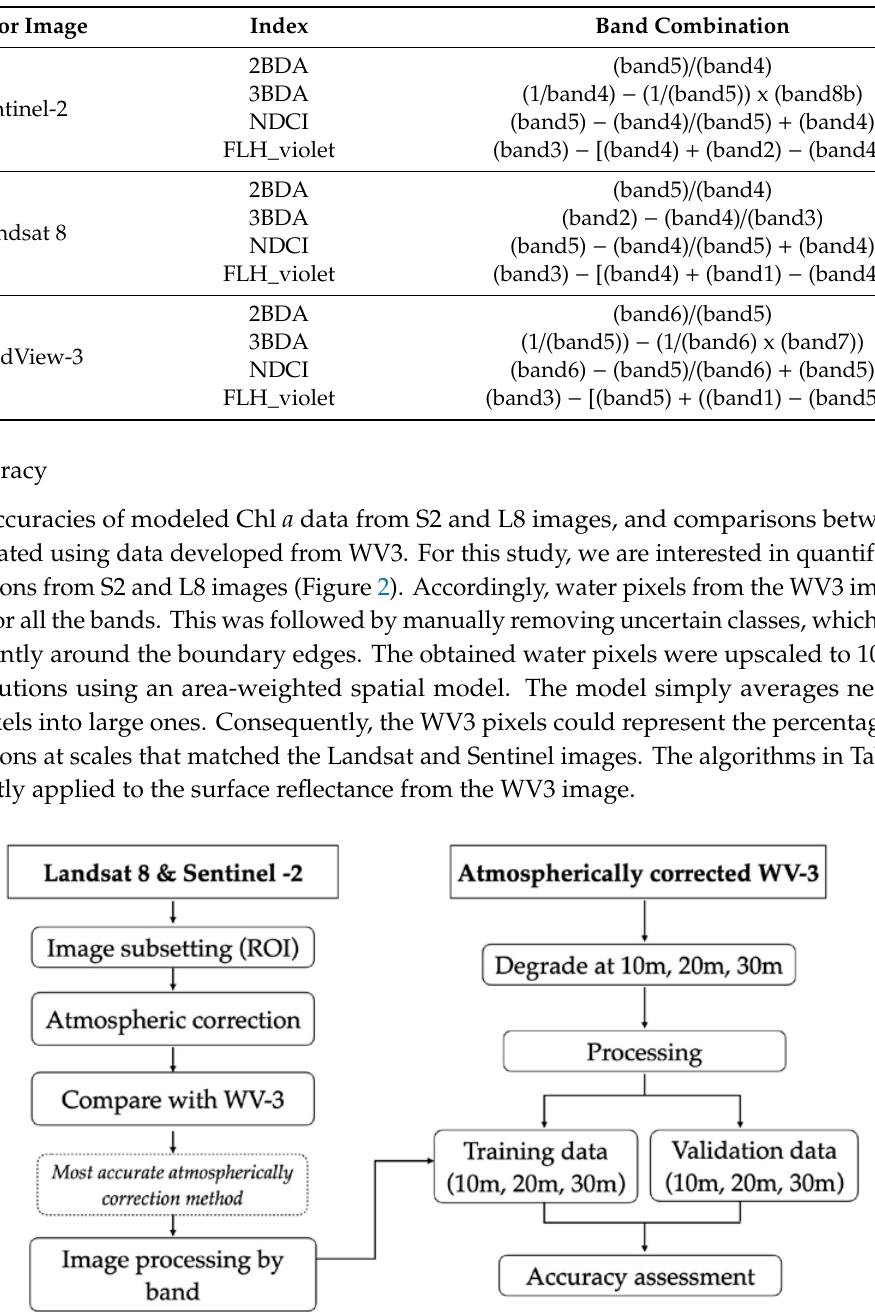
Table 3. Band Math for each algorithm used to derive Chl a concentration in Lake Chad.